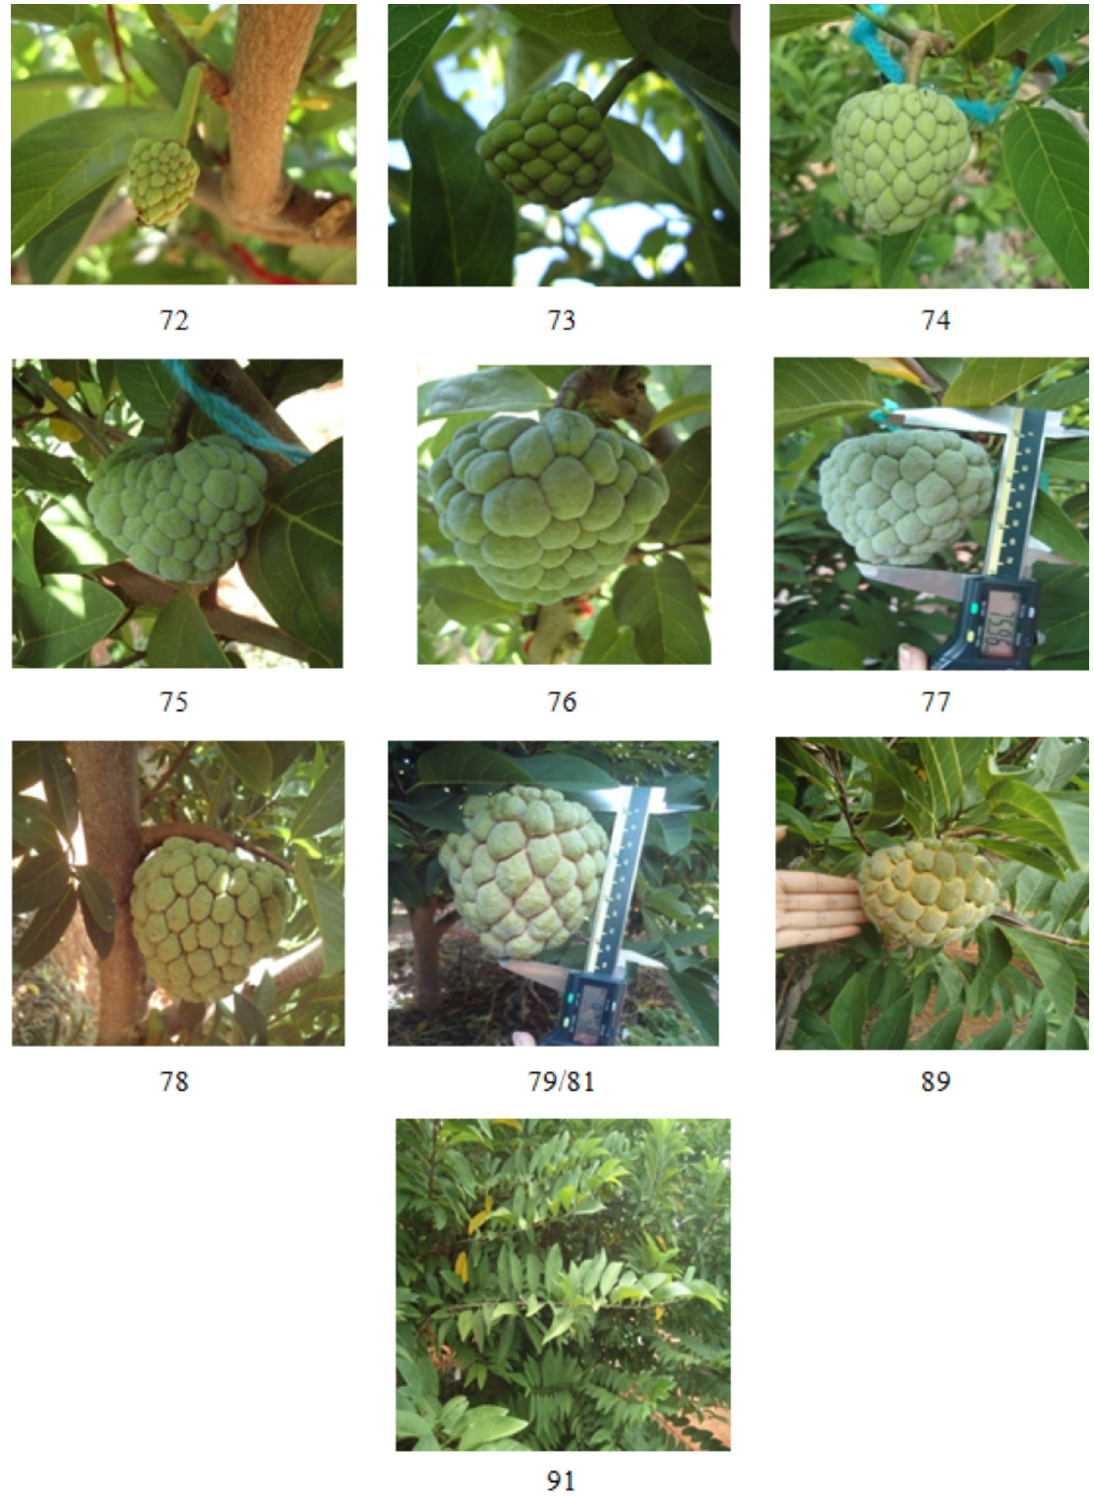
Figure 4 - Principal growth stages (72-91) of sugar-apple ( A. squamosa L.) as described by the BBCH scale in Janaúba, Minas Gerais,